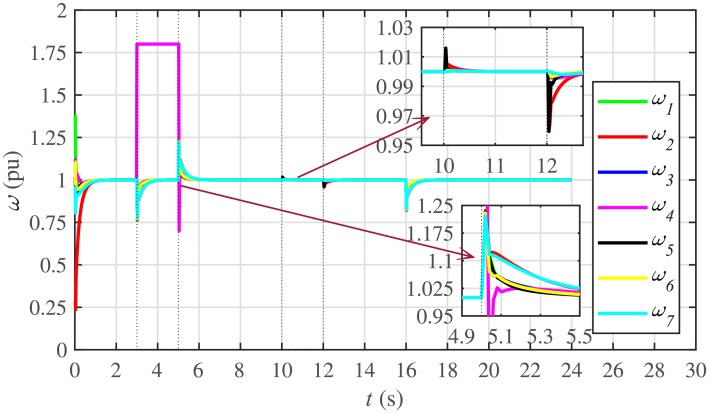
Frequency regulation under case 2.